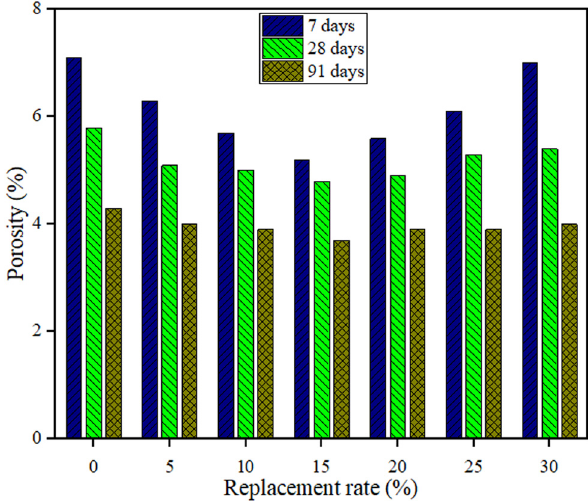
Figure 11: Porosity of RHA – SCC [ 54 ]